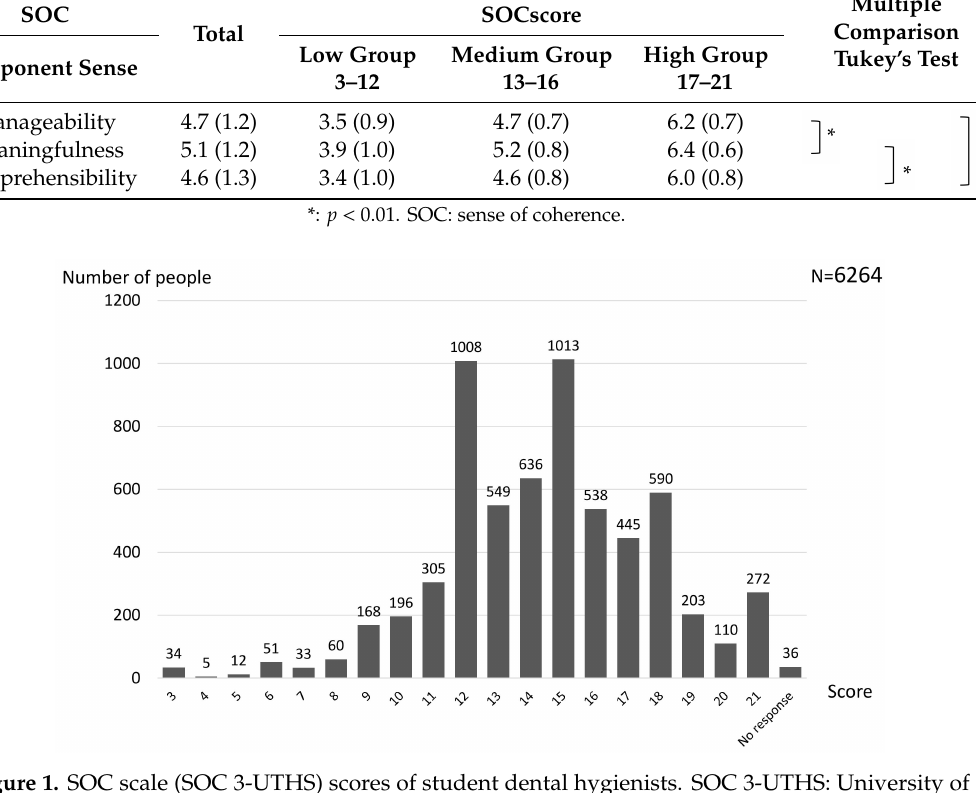
Figure 1. SOC scale (SOC 3-UTHS) scores of student dental hygienists. SOC 3-UTHS: University of Tokyo Health Sociology version of the sense of coherence 3 scale. Table 2. View of profession and attitude to work by SOC score